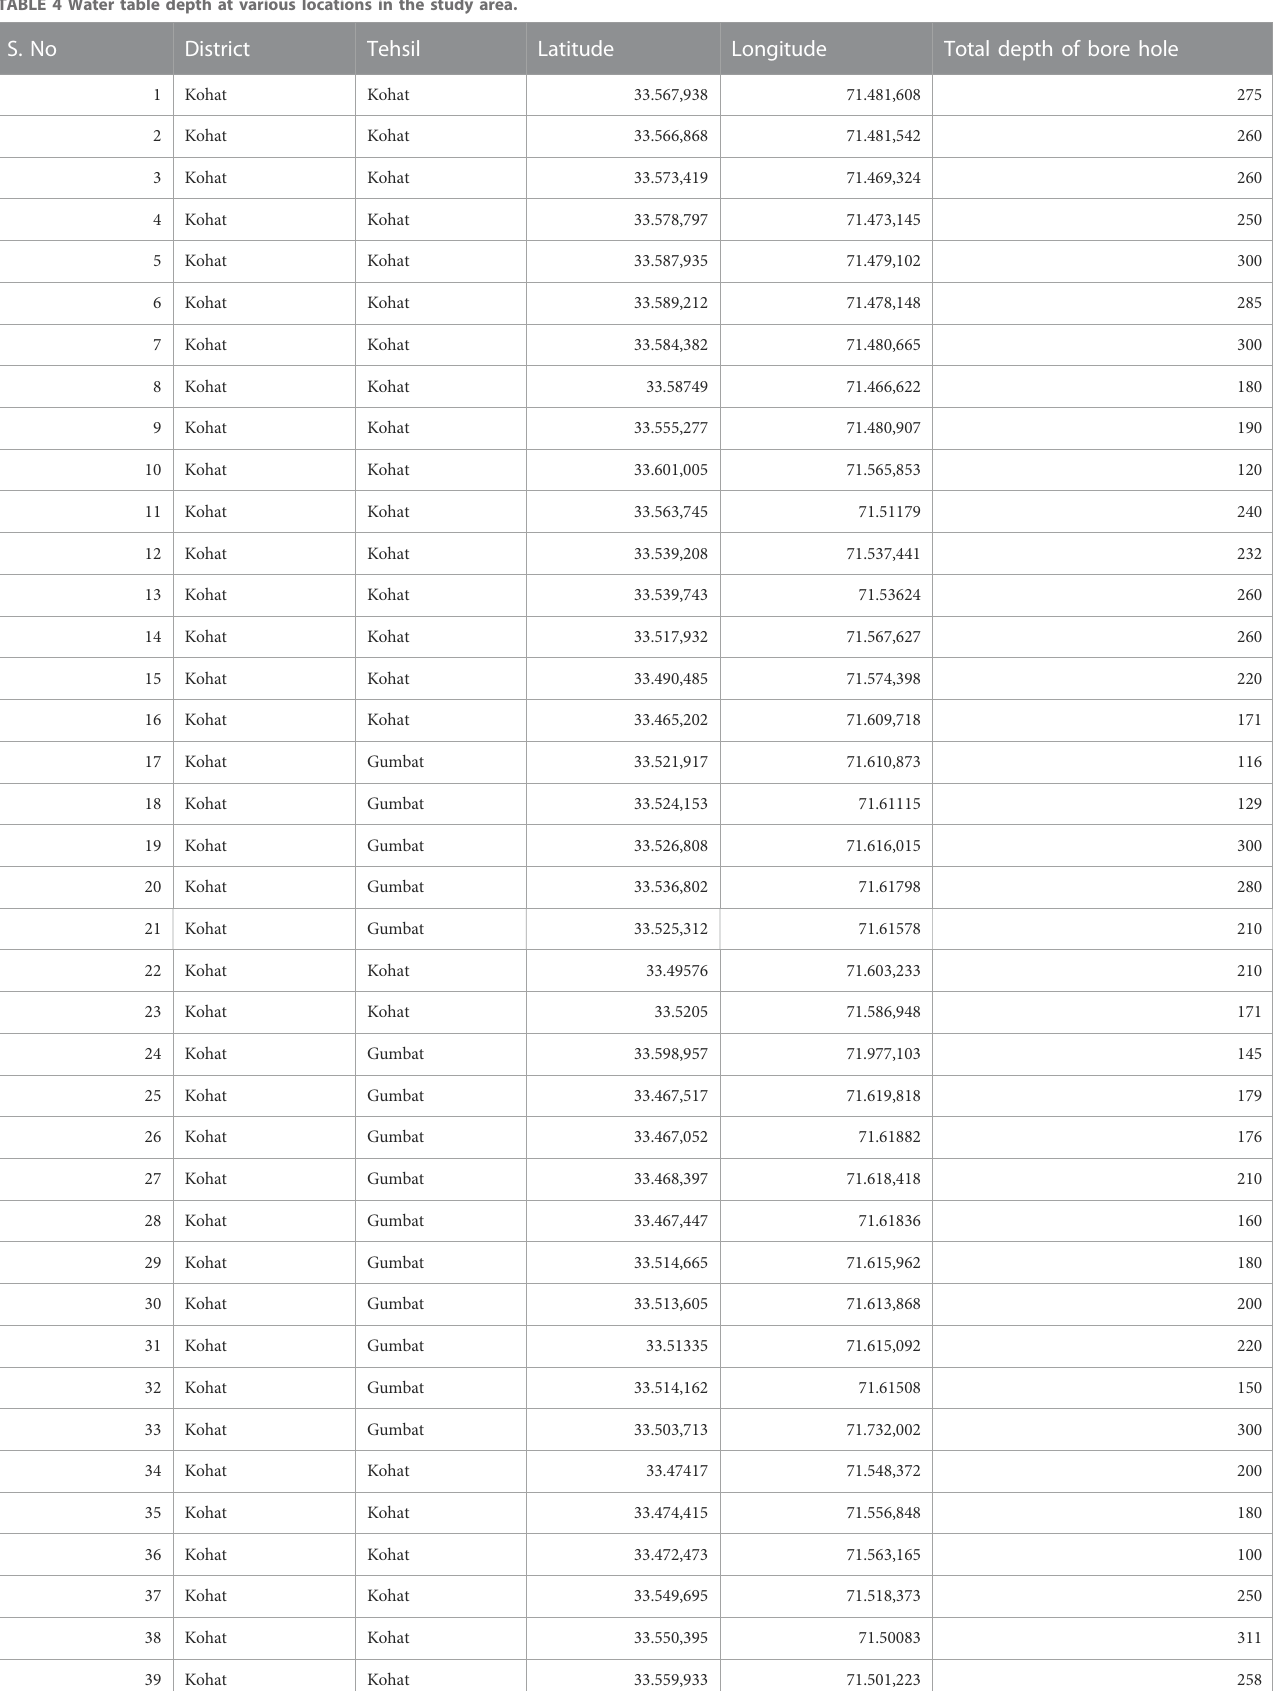
TABLE 4 Water table depth at various locations in the study area. S.